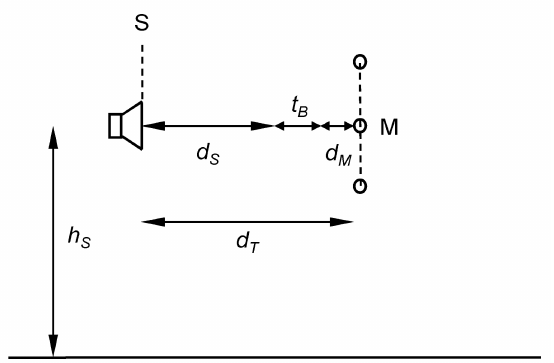
Figure 4. Diagram of the set-up for reference measurement in the free sound field to determine the sound insulation index [29]; the symbols used in Figure 4 are defined in Figure 2.